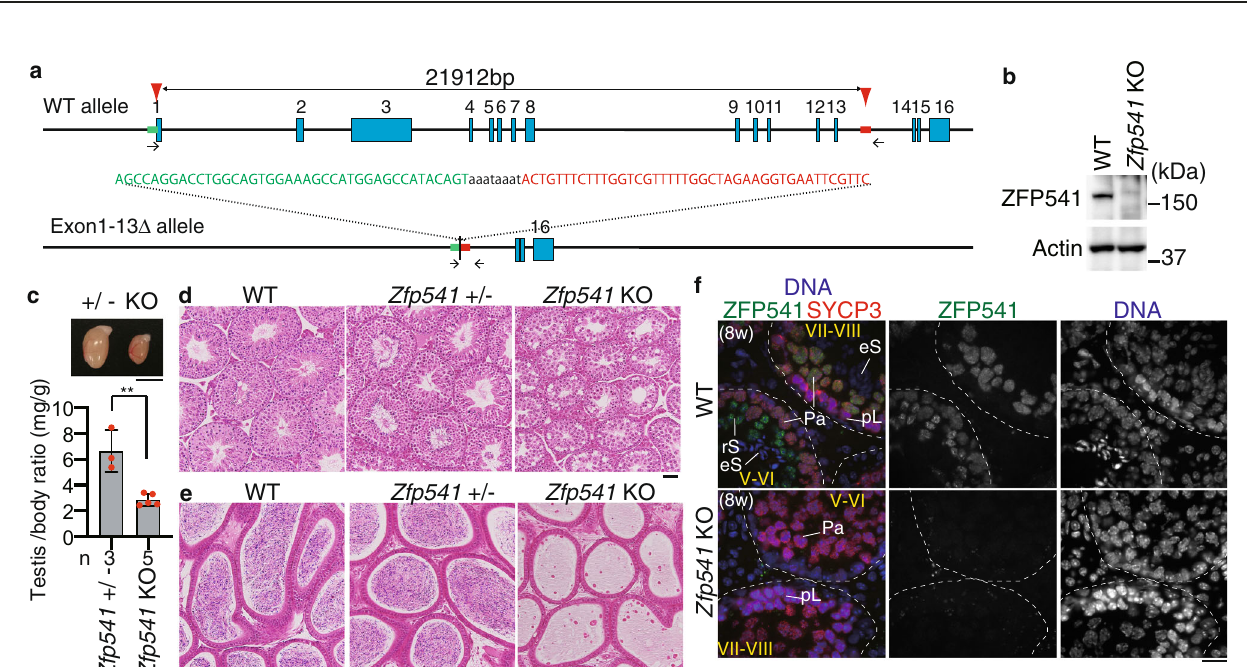
Fig. 1 Zfp541 was identi fi ed as a MEIOSIN-STRA8 target gene. a Genomic view of MEIOSIN and STRA8 binding peaks over the Zfp541 locus. Genomic coordinates derived from Ensembl. b The expression of Zfp541 in WT (P8 and P10), Meiosin KO, and Stra8 KO testes was examined by RT-qPCR. Three animals for each genotype were used. The graph shows the expression level of Zfp541 normalized by that of GAPDH with SD. The expression level of Zfp541 in P10 WT was set to 1. Statistical signi fi cance (two-tailed t -test) is shown by *** p -value = 0.999 × 10 − 3 . Biologically independent mice ( N = 3) for each genotype were examined. c The tissue-speci fi c expression pattern of Zfp541 was examined by RT-PCR. Testis RNA was obtained from embryonic day 18 (E18), 3-weeks-old (3w), and 8-weeks-old (8w) male mice. Ovary RNA was obtained from adult 8-weeks-old (8w) female mice. RT − indicates control PCR without reverse transcription. The data were acquired from two separate experiments. d The expression patterns of Zfp541 in the embryonic ovary and testis were examined by RT-qPCR. Average values normalized to E12.5 gonad are shown with SD from technical triplicates. N = 1 gonadal sample for each embryo. e Chromosome spreads of WT spermatocytes were immunostained as indicated. Biologically independent mice ( N = 2) were examined in two separate experiments. Scale bar: 5 μ m. f Seminiferous tubule sections in WT testis (8-weeks old) were immunostained as indicated. Lep: leptotene, Pa: pachytene, l.P: late pachytene spermatocyte, rS: round spermatid, eS: elongated spermatid. Boundaries of the seminiferous tubules are indicated by white dashed lines. Roman numbers indicate the seminiferous tubule stages. Biologically independent mice ( N = 3) were examined in three separate experiments. Scale bar: 25 μ m. g Seminiferous tubule sections in WT testis (P21) were immunostained as indicated. Arrow and arrowhead indicate H1t- negative and H1t-positive pachytene spermatocyte, respectively. Biologically independent mice ( N = 5) were examined in two separate experiments. Scale bar: 25 μ m.